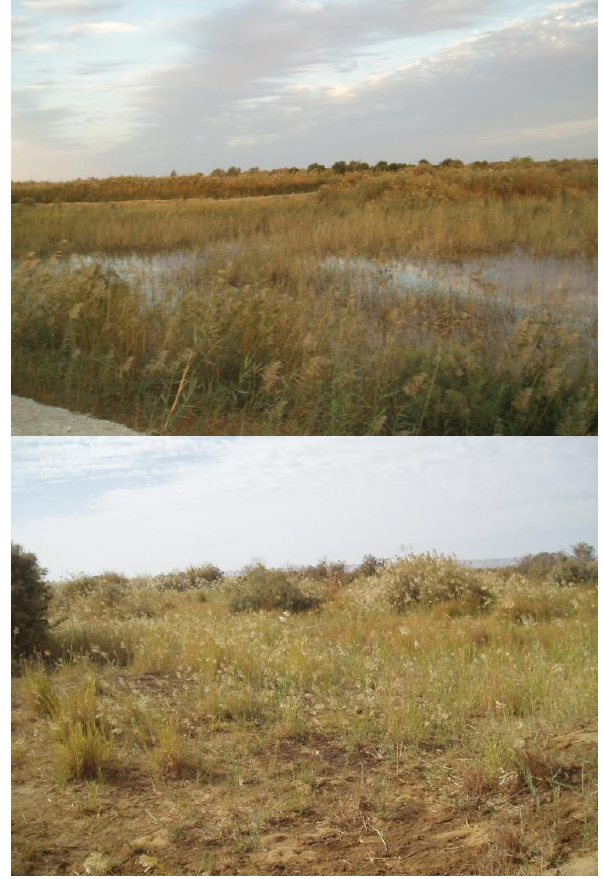
Fig 3: Field photos show the development of waterlogging within the Farafra Oasis, and 599 Fig. 3. Field photos show the development of waterlogging within the growth of plant and shrub species distinctive to saline and waterlogged soil. 600 the Farafra Oasis, and the growth of plant and shrub species distinc- 601 tive to saline and waterlogged